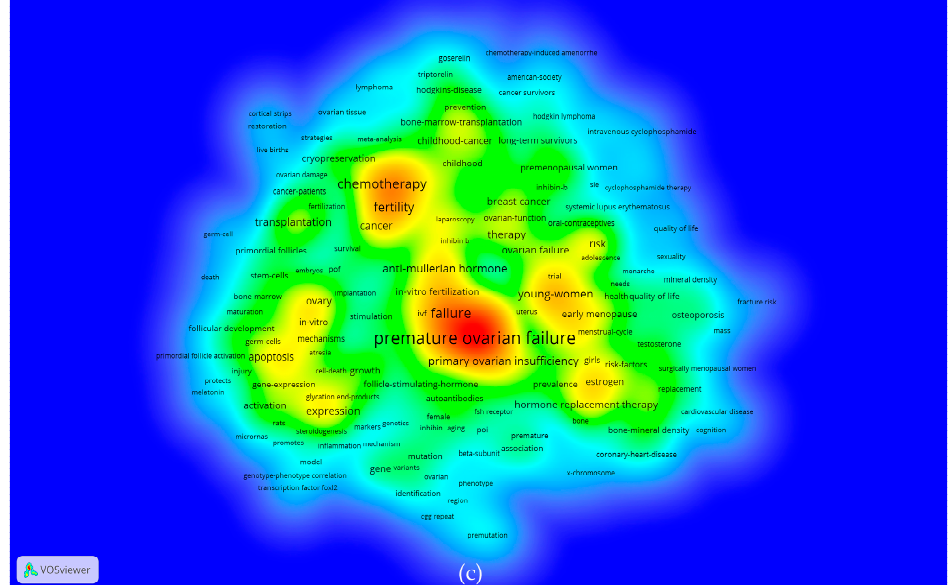
Figure 7. Co-occurrence analysis of keywords. ( a ) Network visualization mapping of the keywords. The nodes represent keywords and the size of the nodes is proportional to the frequency of the keywords. The nodes and lines of different colors symbolize diverse keyword clusters. ( b ) Overlay visualization mapping of the keywords. Distribution of keywords on the average appearance time. The color of each node corresponds to the average publication year. The size of a node is proportional to the frequency of occurrence of the keyword, and the thickness of the connecting line indicates the strength of the keywords’ co-occurrence link. ( c ) Density visualization mapping of the keywords. The closer the keyword node color is to red, the higher the frequency of its co-occurrence. Table 5. Top 5 keywords in each cluster and top 10 keywords in each stage on therapy for POI from 2000 to 2022.